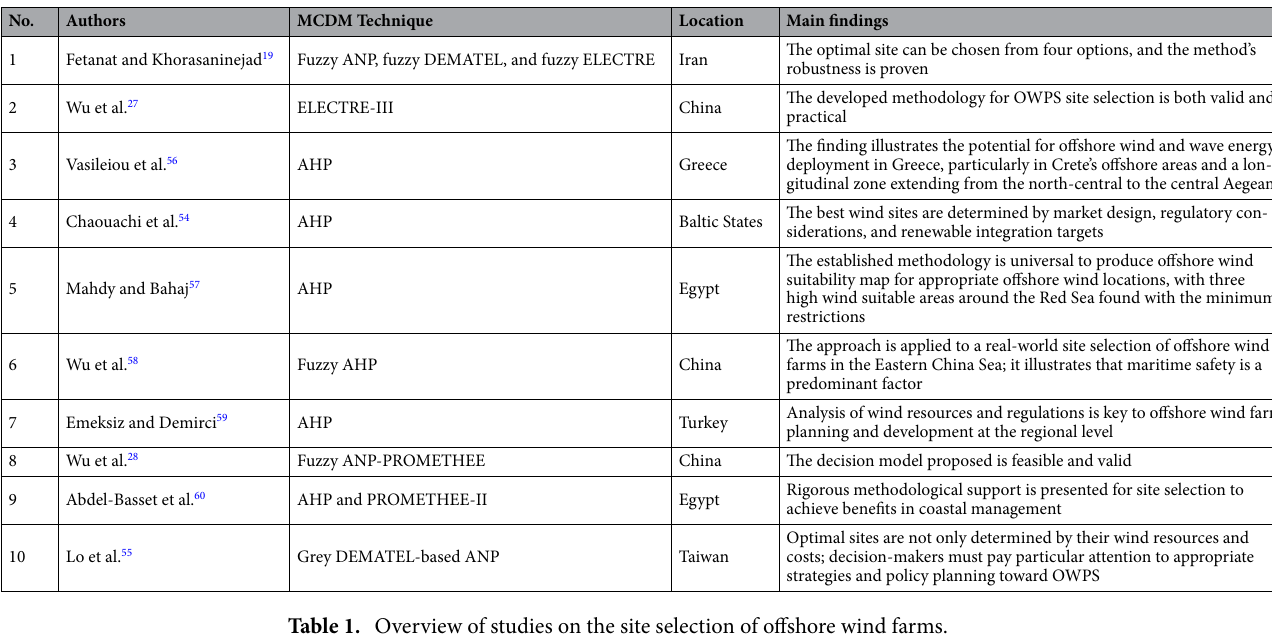
Table 1. Overview of studies on the site selection of offshore wind farms.